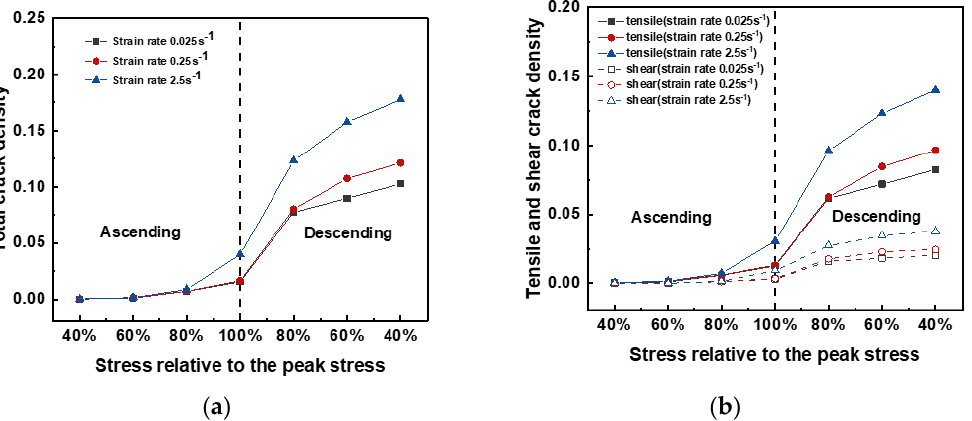
Figure 8. Crack density vs. stress relative to the peak stress for the cases with different loading rates. ( a ) Total crack density, ( b ) tensile and shear crack density.